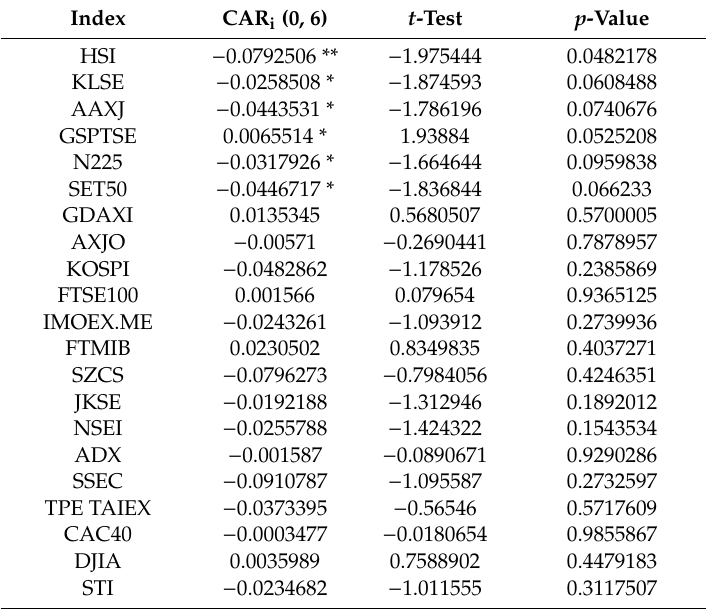
Table 5. Cumulative abnormal return in the event window (0,